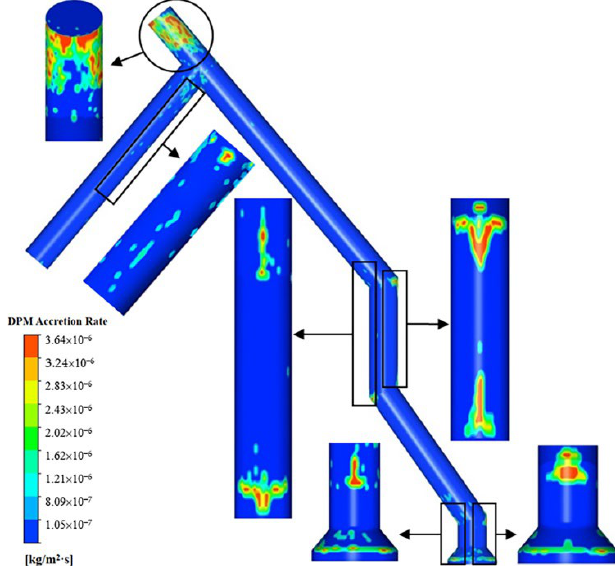
Figure 11. Particle deposition mass rate distribution in the flue.